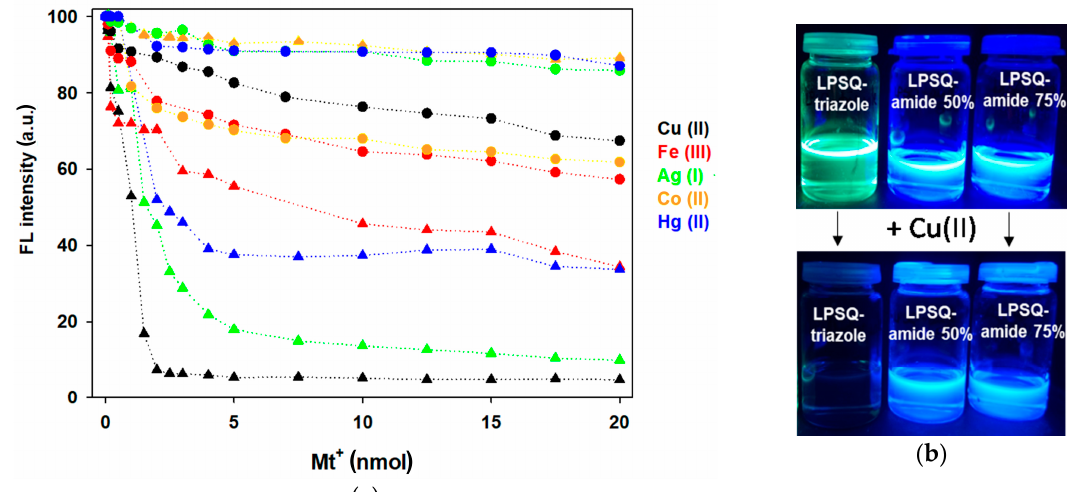
Figure 16. ( a ) Comparison of FL emission intensity of ▲ —LPSQ-triazole-Py (in THF) and ● —LPSQ-amide50-Py (in DMF) in the presence of perchloric (VII) acid salts; ( b ) visible changes of FL emission intensity of LPSQ-triazole-Py, LPSQ-amide50-Py and LPSQ-amide75-Py in the presence of Cu(II) ions (n Cu(II) = n Py ).